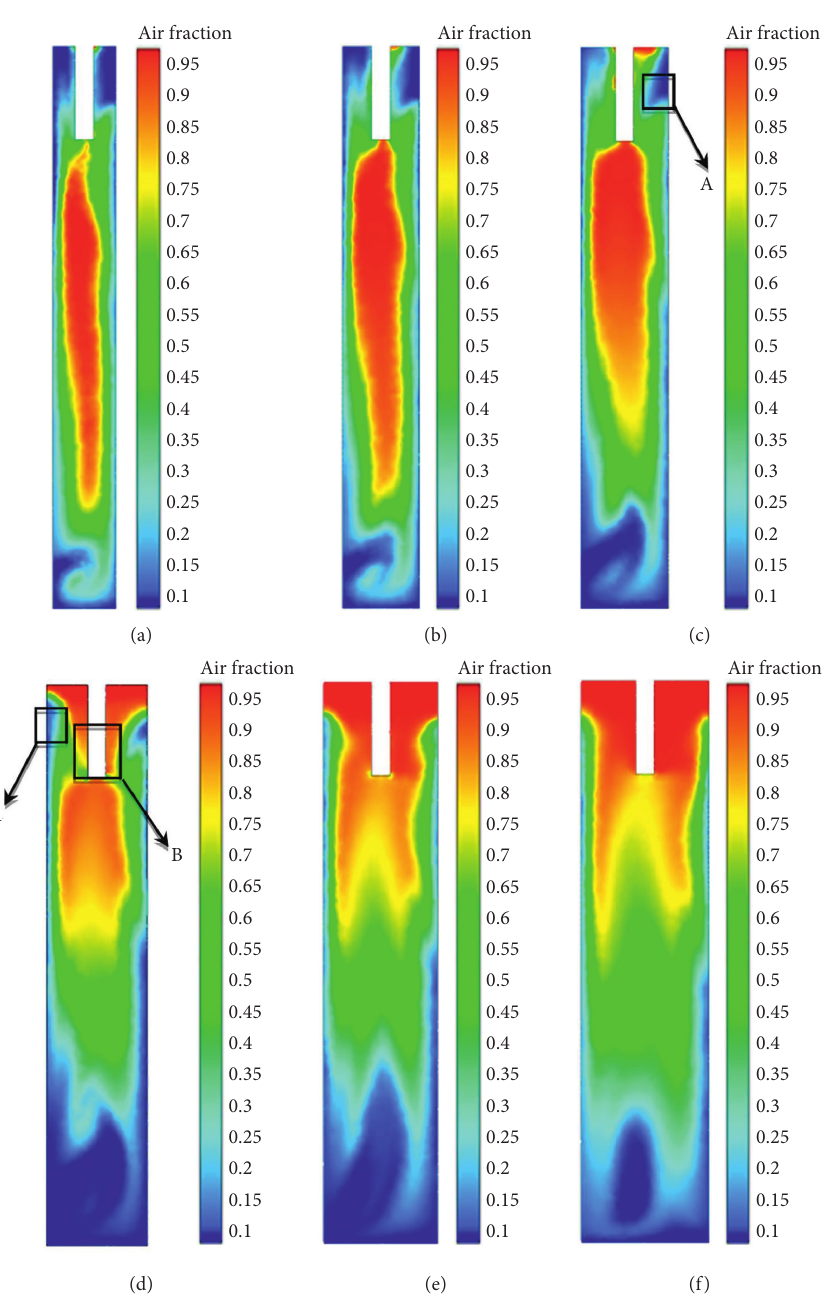
Figure 12: Gas volume distribution of each section at different cylinder diameters. (a) d d sep � 14 mm. (d) d sep � 16 mm. (e) d sep � 18 mm. (f) d sep � 20